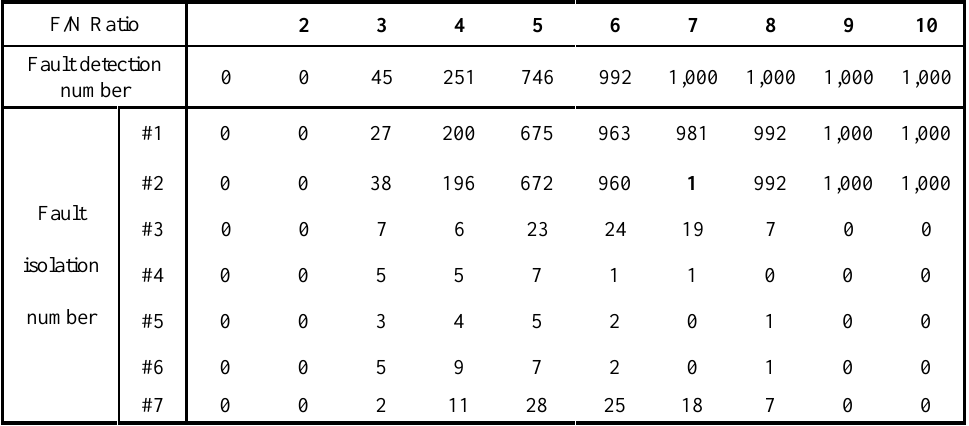
Table 5. Modidfied-EPSA FDI performance in